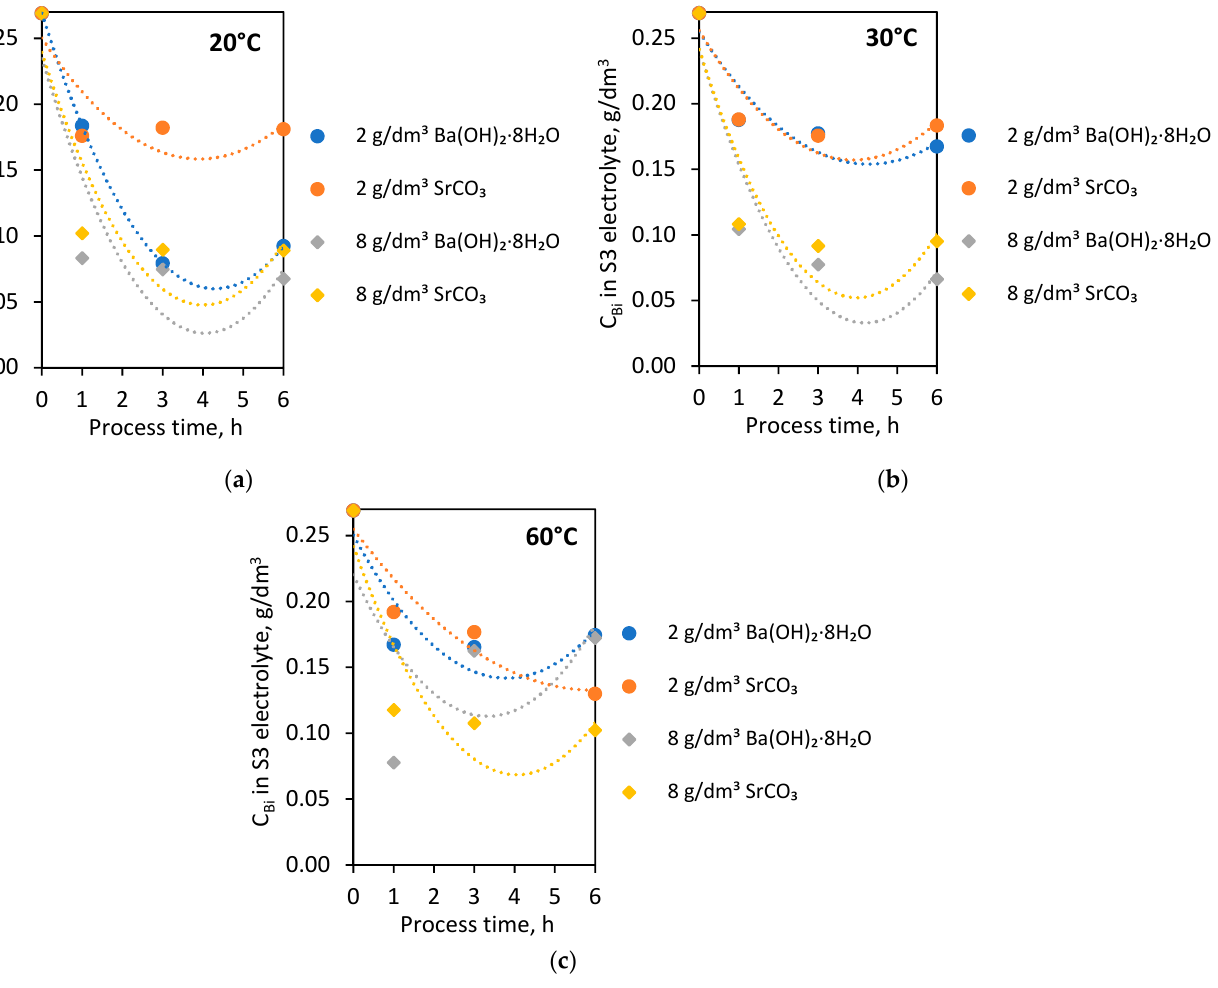
Figure 4. Dependence of Bi concentration in S3 electrolyte on process time with barium hydroxide octahydrate and strontium carbonate in ( a ) 20 °C; ( b ) 30 °C; ( c ) 60 °C. After the first hour of the process, the Bi concentration dropped to below 0.2 g/dm 3 ,